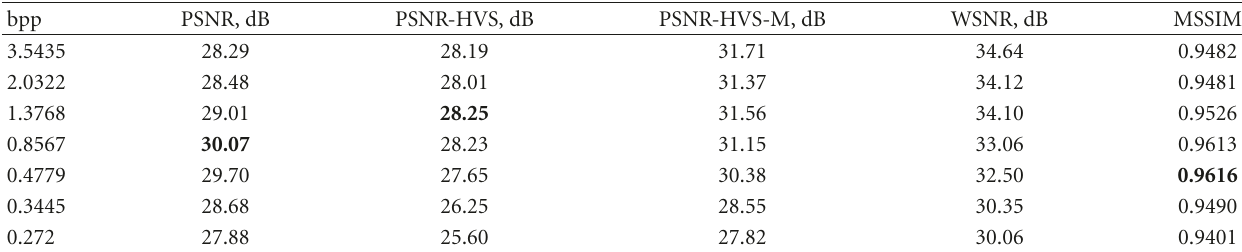
Table 5: Results for the image Barbara for the coder SPIHT, σ 2 =